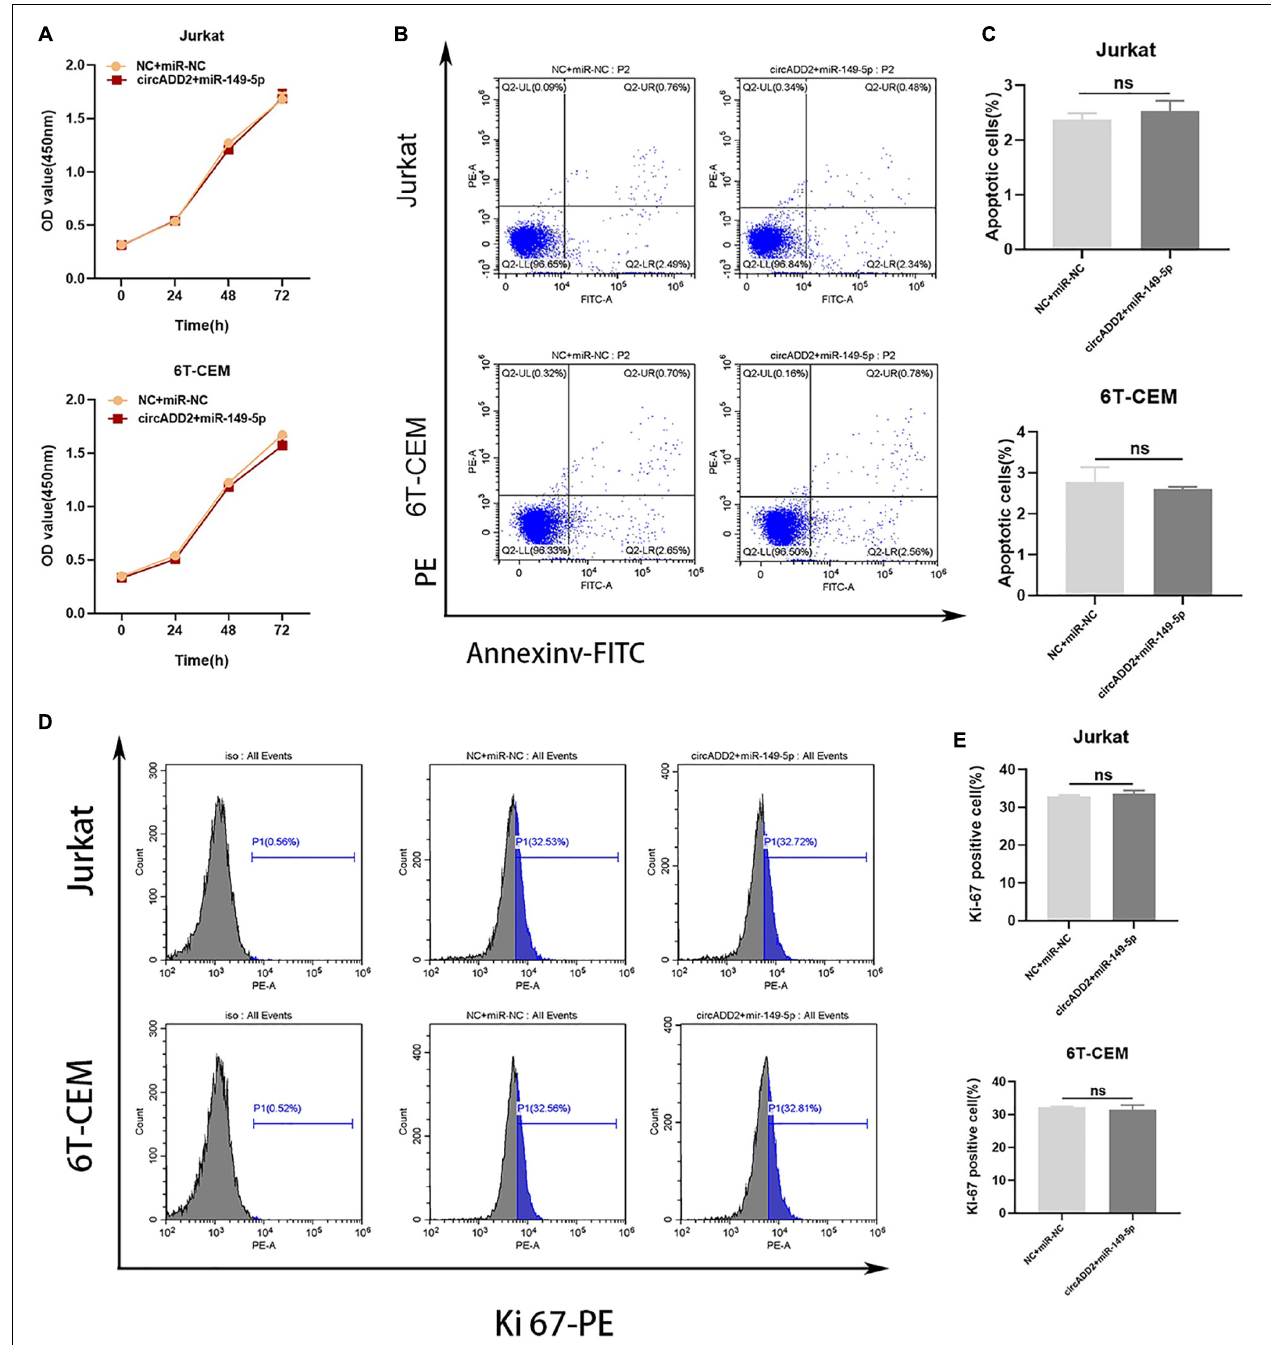
FIGURE 5 | MiR-149-5p overexpression eliminated the effect of circADD2 overexpression. (A) CCK-8 assay showed no significant change in proliferation rate after circADD2 overexpressing plasmid and miR-149-5p were co-transfected into Jurkat and 6T-CEM cells. (B,C) Apoptotic rate of cells transfected with NC + miR-NC or circADD2 + miR-149-5p was analyzed by flow cytometry. Compared with the NC + miR-NC groups, there was no change in apoptosis in the circADD2 + miR-149-5p groups. (D,E) There was no remarkable difference of the levels of Ki-67-positive cells between circADD2 + miR-149-5p group and NC + miR-NC group. Data were showed as mean ± SD and analyzed by unpaired t -test, ns: no